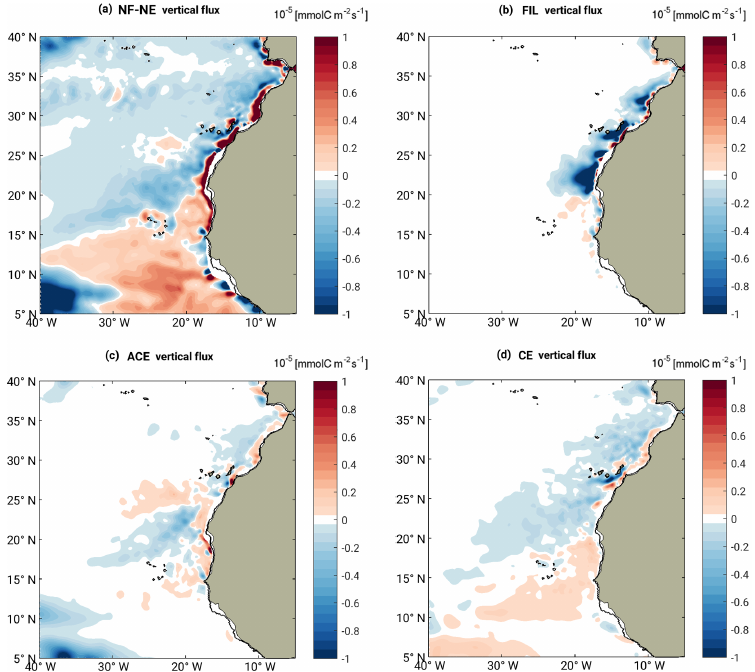
Figure B11. Decomposition of the vertical advective transport of C org into: (a) non-filament-non-eddy (NF-NE) flux, (b) filament (FIL) flux, (c) anticyclonic (ACE) flux and (d) cyclonic (CE) flux. Fluxes [mmolCm − 2 s − 1 ] are sliced at a depth of